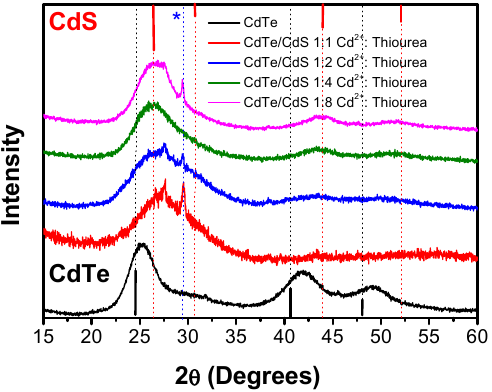
Figure 10. X-ray diffraction patterns of the CdTe and CdTe/CdS core/shell growth with Cd 2+ :thiourea (S 2– ) molar ratios of 1:1, 1:2, 1:4, and 1:8. * Impurities or byproducts not identified in the JCPDS database.